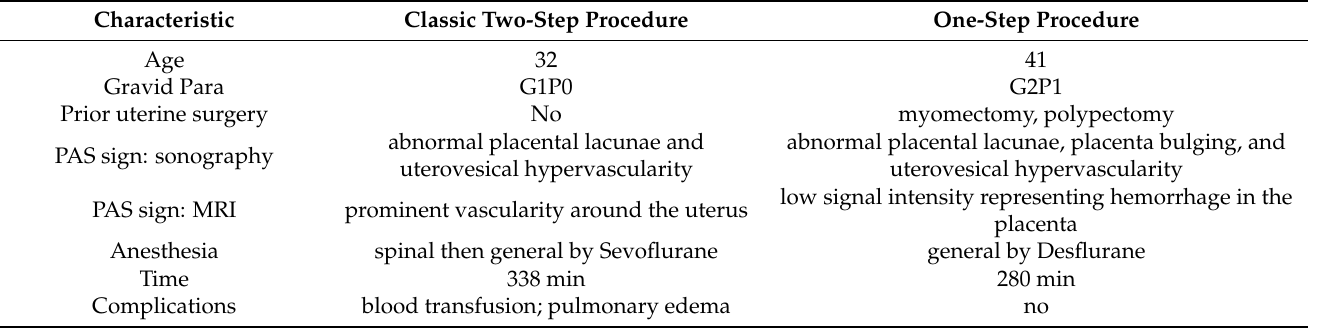
Table 1. The comparison of one-stage and two-stage intraoperative uterine artery